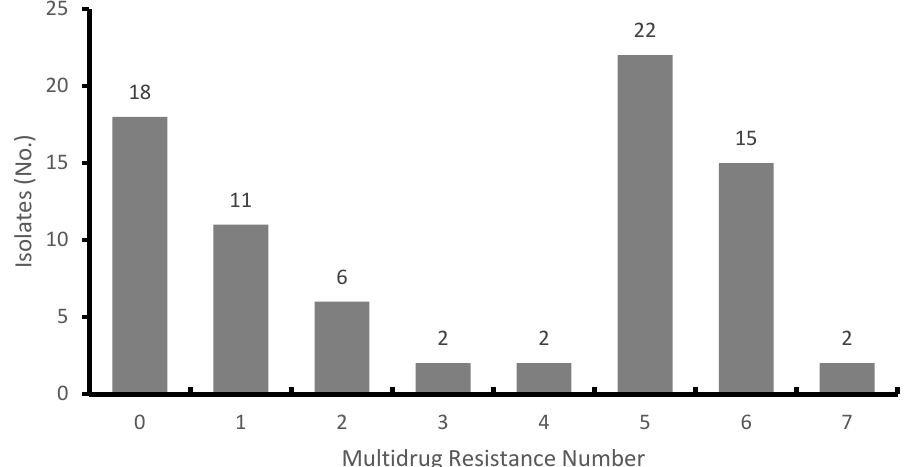
Figure 3. Multidrug Resistance of 78 E. coli strains to 8 Antibiotics. All 78 E. coli isolates were collected and analyzed for multi-drug resistance with tetracycline, ciprofloxacin, streptomycin, gentamycin, lincomycin, cefothiophene, amoxicilin, and penicillin.